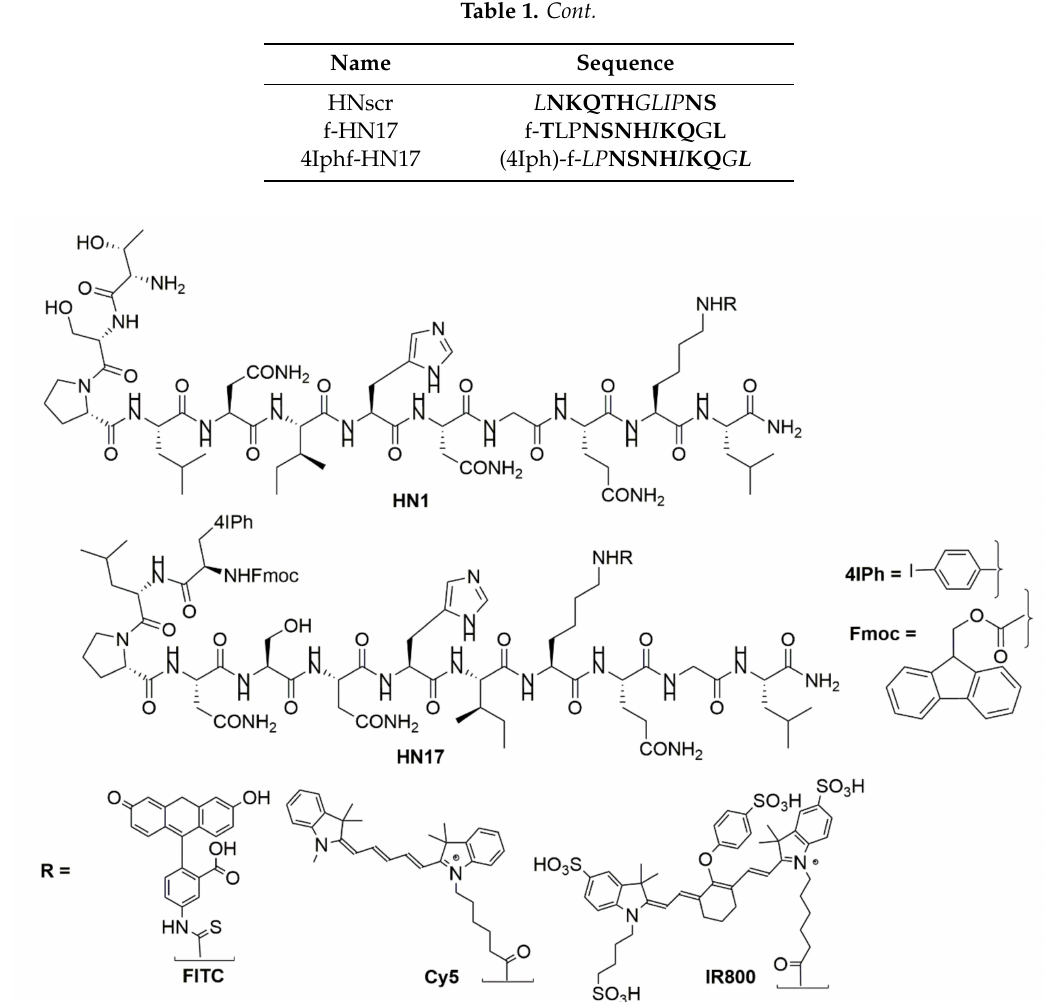
Figure 1. Chemical structures of HN1, 4Iphf-HN17, and the dye labels, FITC, Cy5, and